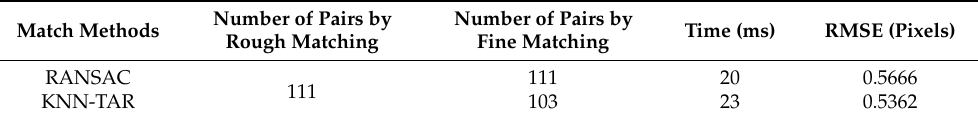
Figure 10. An ASTER (Advanced Spaceborne Thermal Emission and Reflection Radiometer) image pair: ( a ) Acquired on 15 August 2020; ( b ) acquired on 20 October 2020; ( c ) the stitched ASTER image. Table 3. Comparison of TAR and RANSAC algorithms for ASTER images. Table 3. Comparison of TAR and RANSAC algorithms for ASTER images.